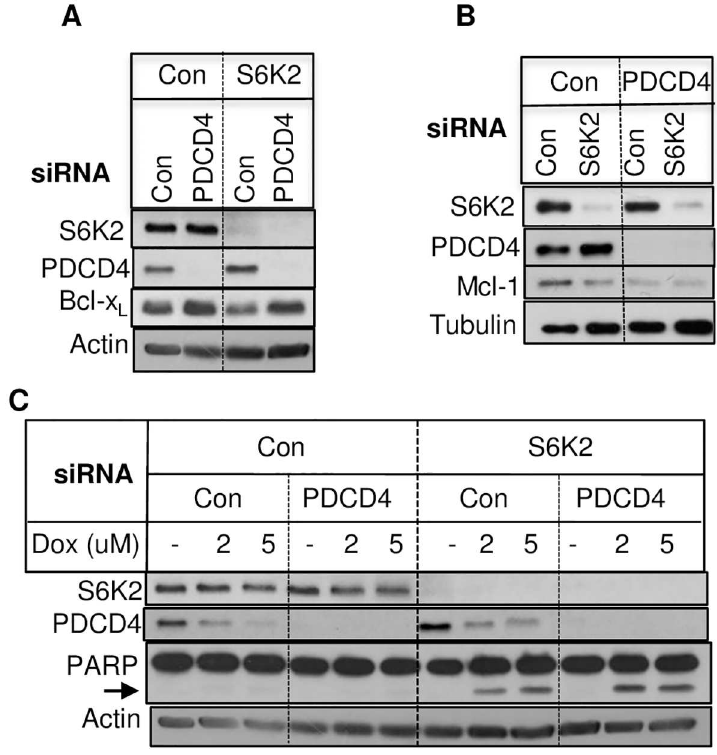
Fig 3. The effect of PDCD4 knockdown on anti-apoptotic Bcl-2 family proteins. (A & B). T47D cells were transfected with either control non-targeting siRNA, S6K2 siRNA, PDCD4 siRNA or co-transfected with both S6K2 and PDCD4 siRNA, and Western blot analyseswere performed. (C). Cells transfected with indicated siRNAs for 72 h were treated with or without indicatedconcentrations of doxorubicin for 18 h and then Western blot analyseswere performed. The arrow indicatescleavedPARP.